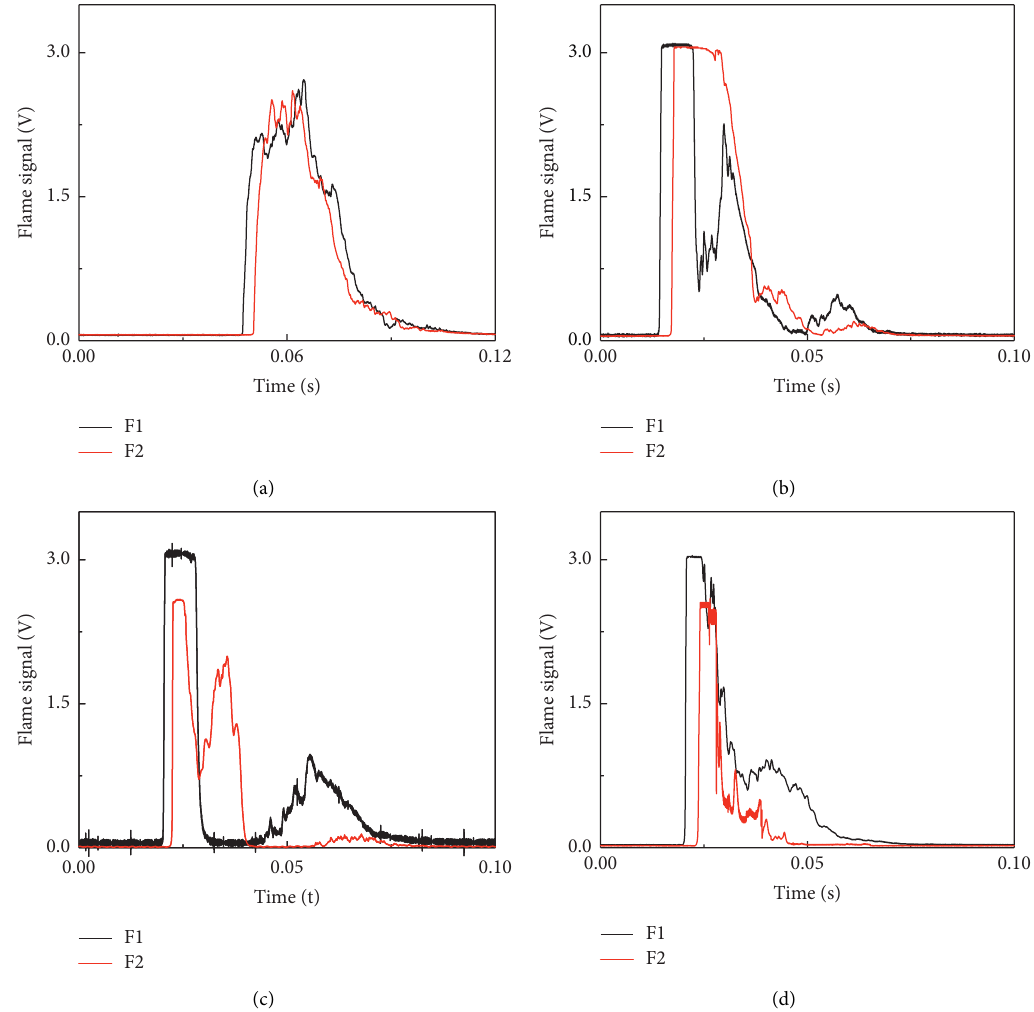
Figure 4: Explosion flame-time curve at the chamber inlet and outlet. (a) Pipeline section without a chamber; (b) chamber of L0.5m × W0.3m × H0.2m; (c) chamber of L0.5m × W0.5 m × H0.2 m; (d) chamber of L0.5m × W0.8 m × H0.2